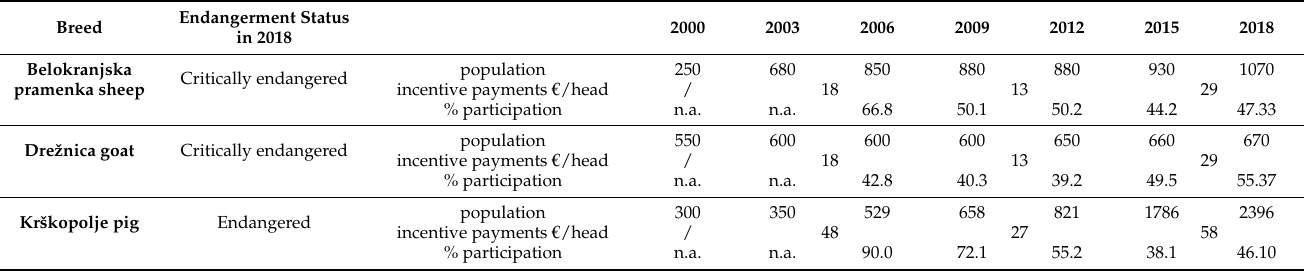
Table A3. Population trends (number of animals) of Slovenian local breeds for the period 2000–2018. Breed/Year